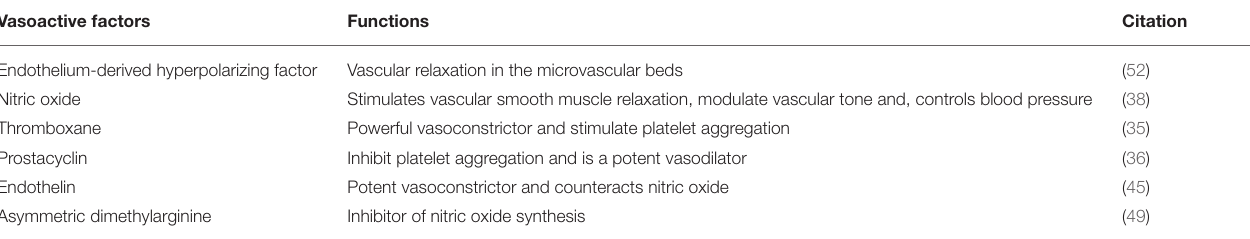
TABLE 1 | Vasoactive factors and their